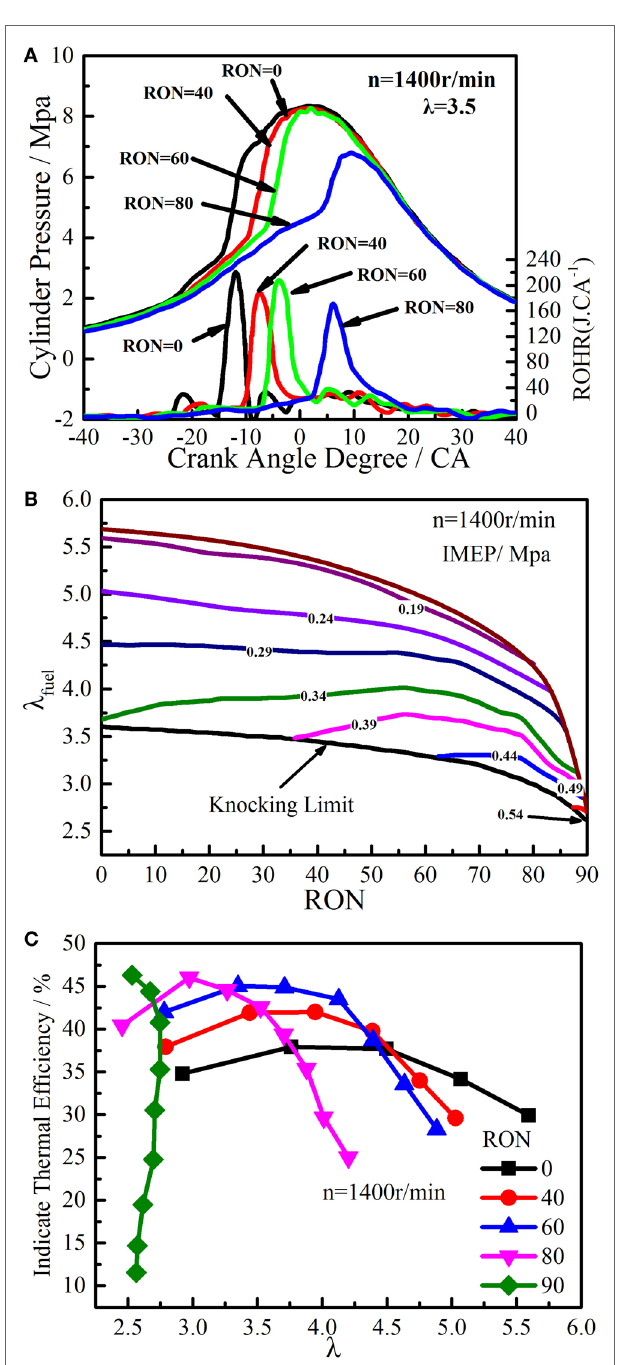
FiGURe 2 | (A) The effects of PRF RON on in-cylinder pressure and heat release rate, (B) the effects of PRF RON on indicated thermal efficiency, (C) the effects of PRF RON on operating load